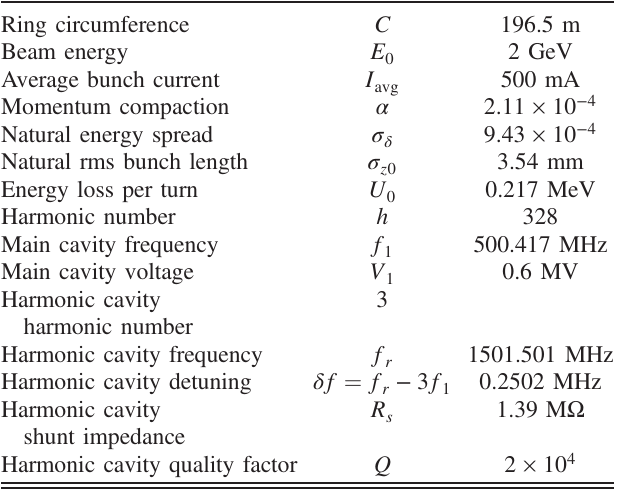
TABLE I. Baseline parameters for ALS-U design. Ring circumference C 196.5